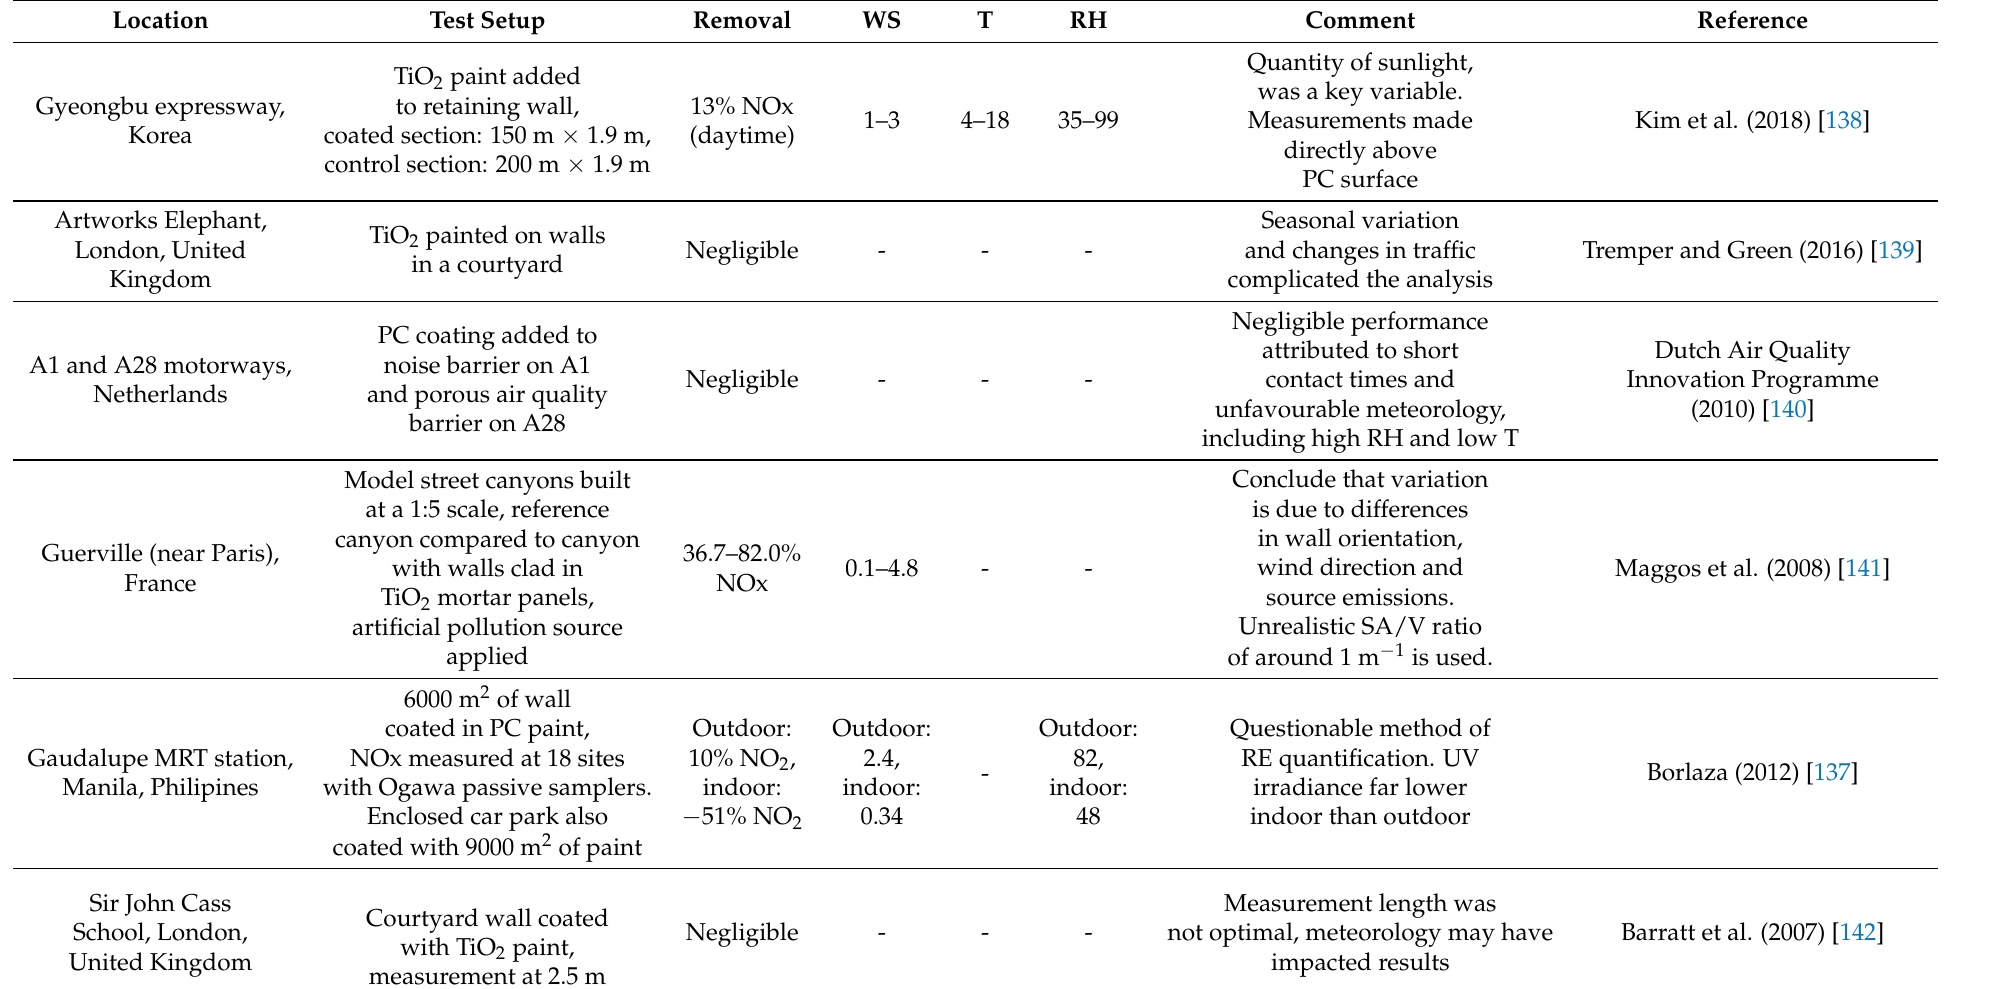
Table 5. Walls. All studies lit with natural light and irradiance not quantified, except for